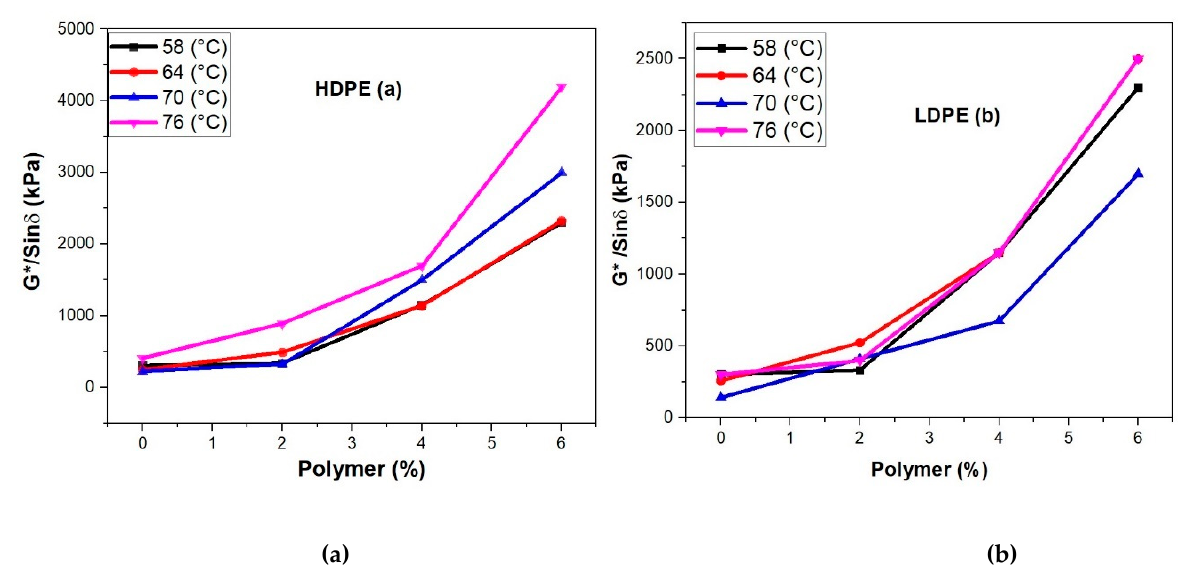
Figure 7. ( a ) A comparison between HDPE modified bitumen and G*/Sin ( δ ) in unaged bi tumen, ( b ) comparison between LDPE modified bitumen and G*/Sin ( δ ) in unaged bitumen.